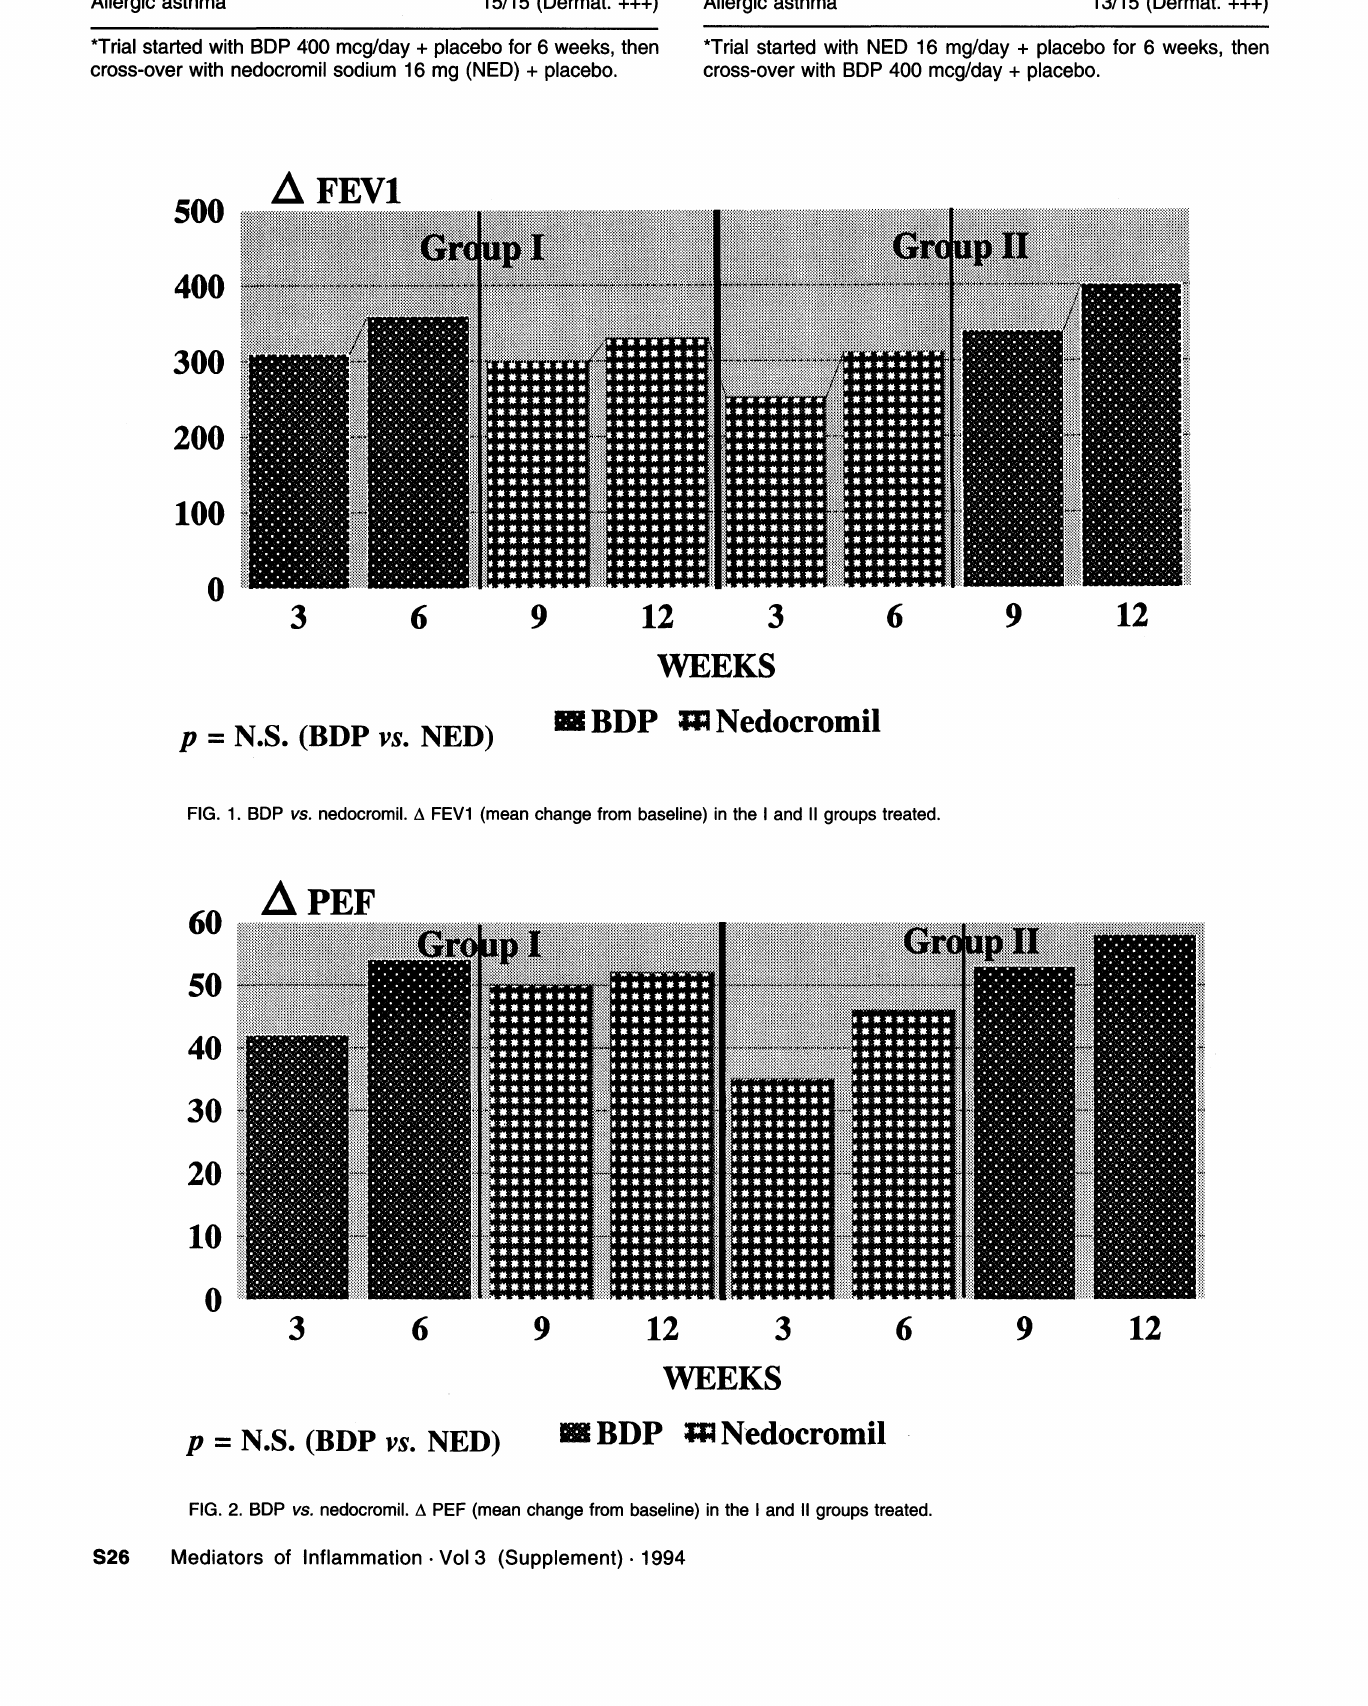
Table 3. Clinical features of children recruited for the trial in treatment group 1" Age, mean (range) Sex FEVl %, mean (range) % Reversibility after Beta-2, mean (range) PC20 Histamine, mean (range)